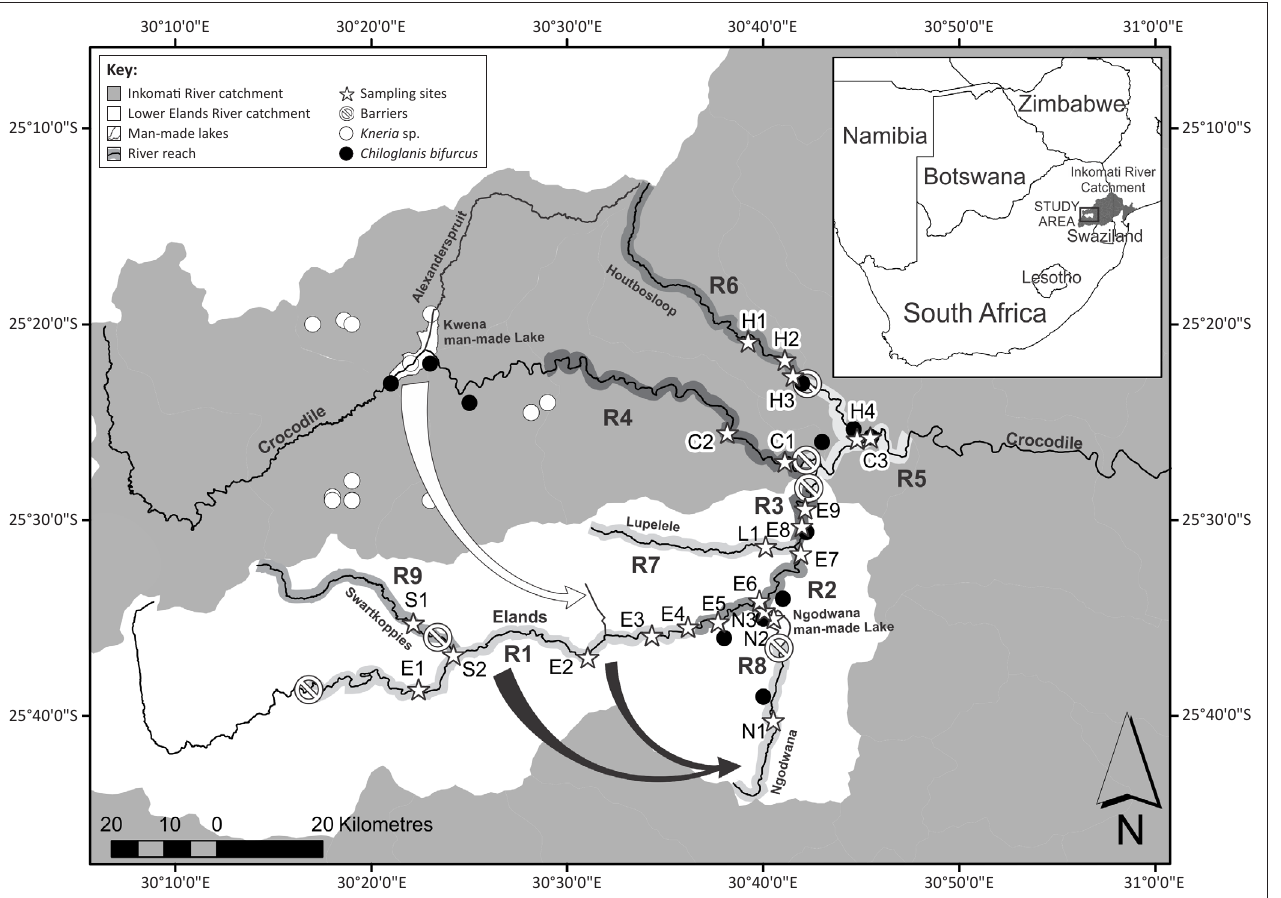
FIGURE 1: The Elands River and associated rivers within the Inkomati River Catchment, southern Africa, where the populations of fishes that were evaluated in the study